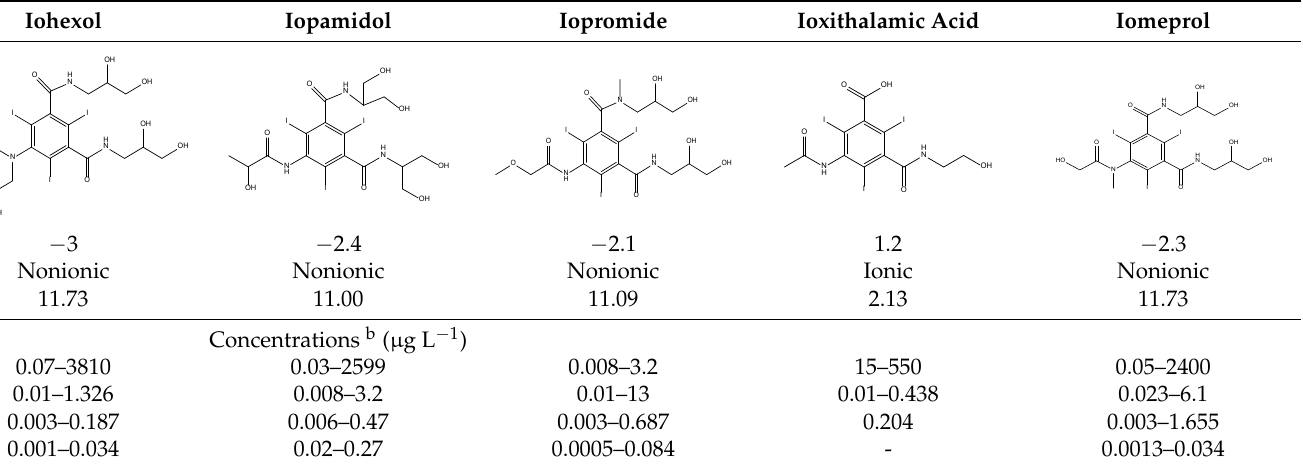
Table 1. Chemical structure and physicochemical properties of ICM.